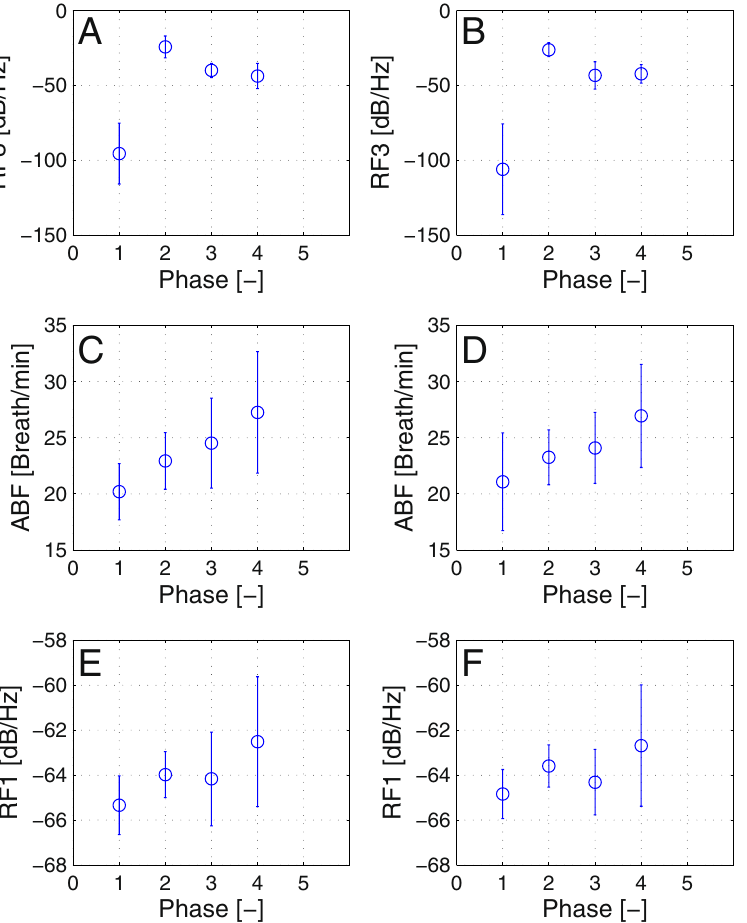
Figure 4. Means and standard deviations of statistically significant parameters against flight phase (1–before engine failure, 2–engine failure, 3–glide, 4–approach and landing). The left column with figure ( A , C ), and ( E ) is for flights with navigation enabled, the figures ( B , D ), and ( F ) are for flights without navigation